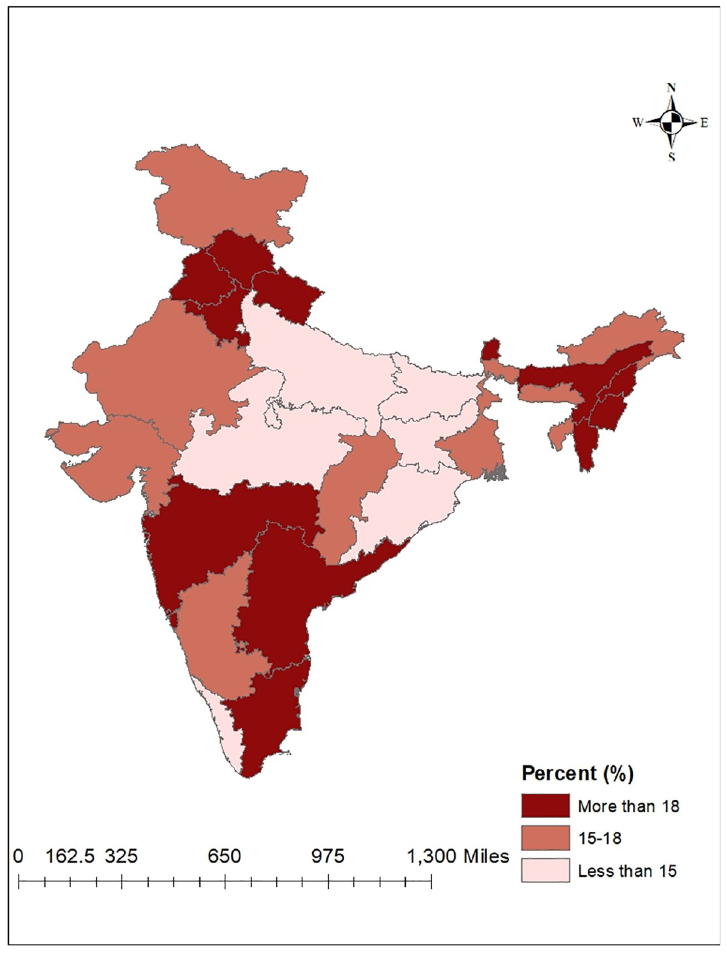
Fig 2. Prevalence of hypertension among men by states of India,